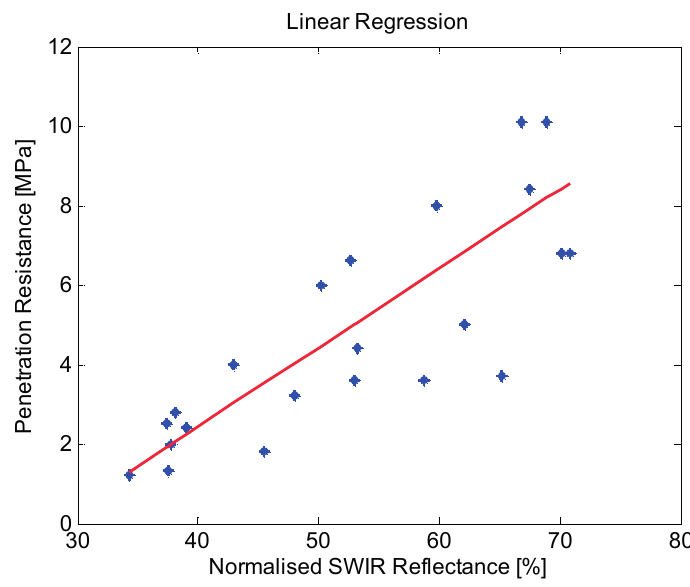
Figure 9. Relationship between soil penetration resistance and normalised SWIR